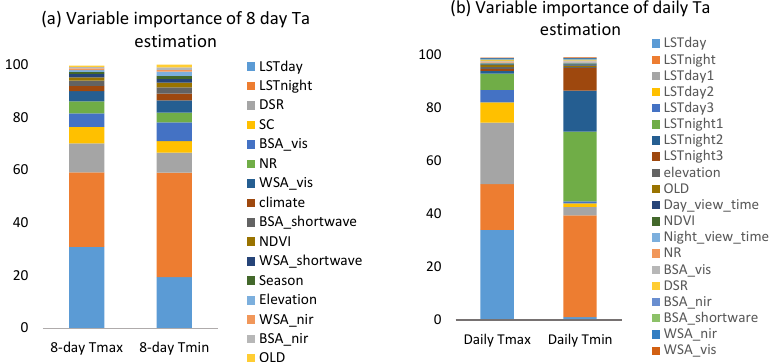
Figure 7. Variable importance (%) of 8-day ( a ) and daily ( b ) Tmax and Tmin in spatial experiments on a global scale.